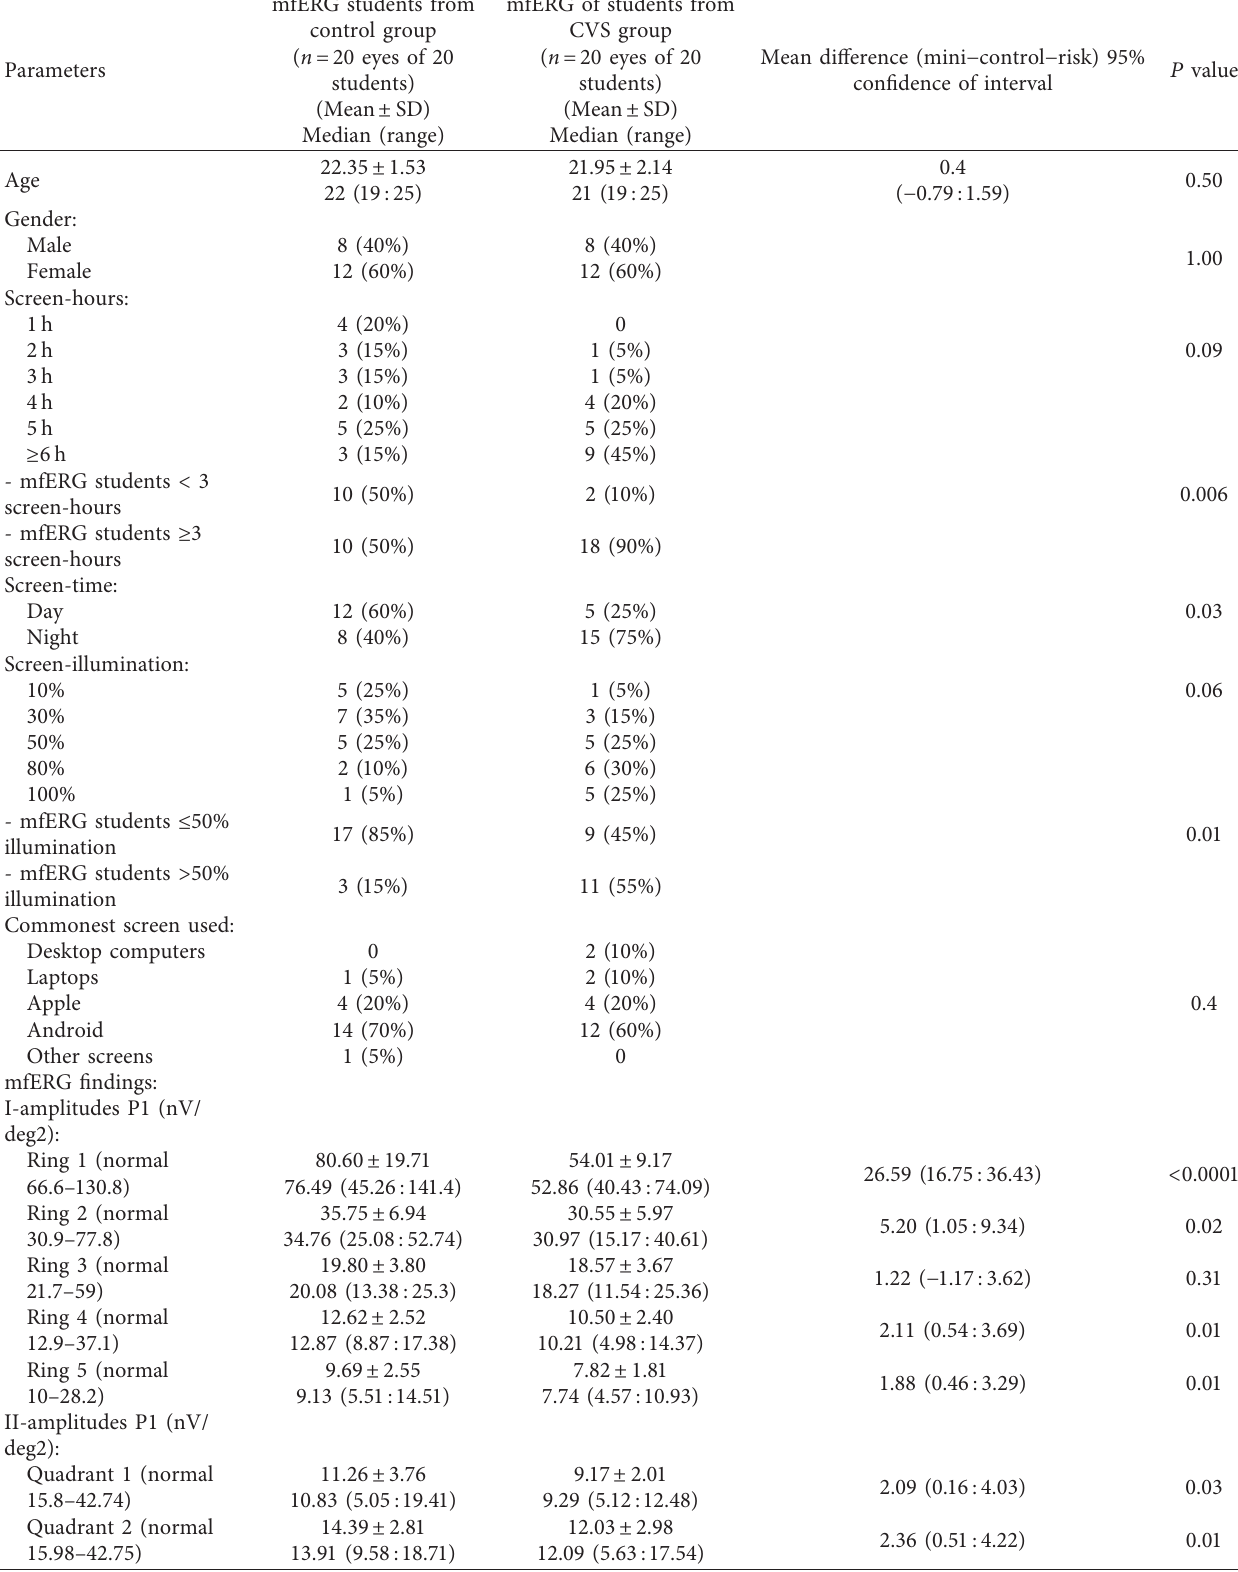
Table 10: Data summary of the mfERG